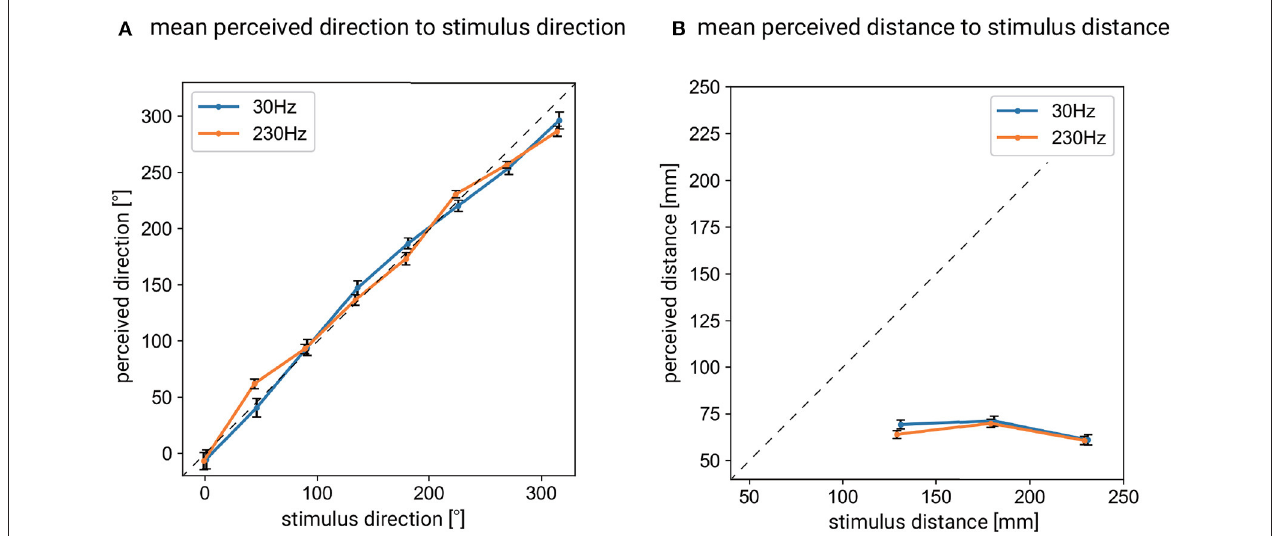
FIGURE 4 | (A) Mean perceived direction for each stimulus direction in the cases of 30 and 230 Hz vibrations. (B) Mean perceived distance for each stimulus distance in the cases of 30 and 230 Hz vibrations. Error bars denote